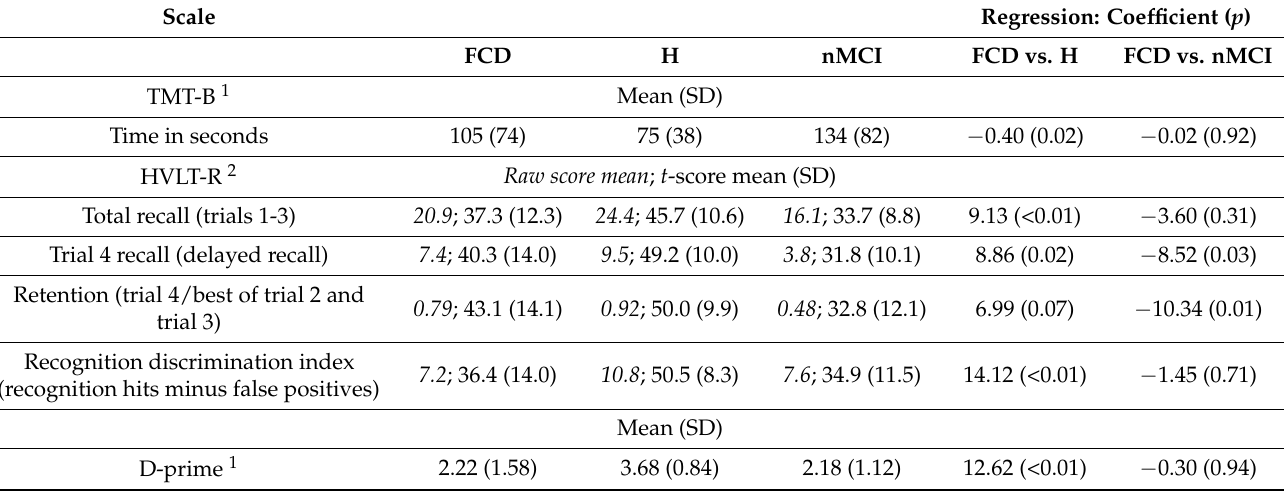
Table 3. Cognitive testing (TMT-B and